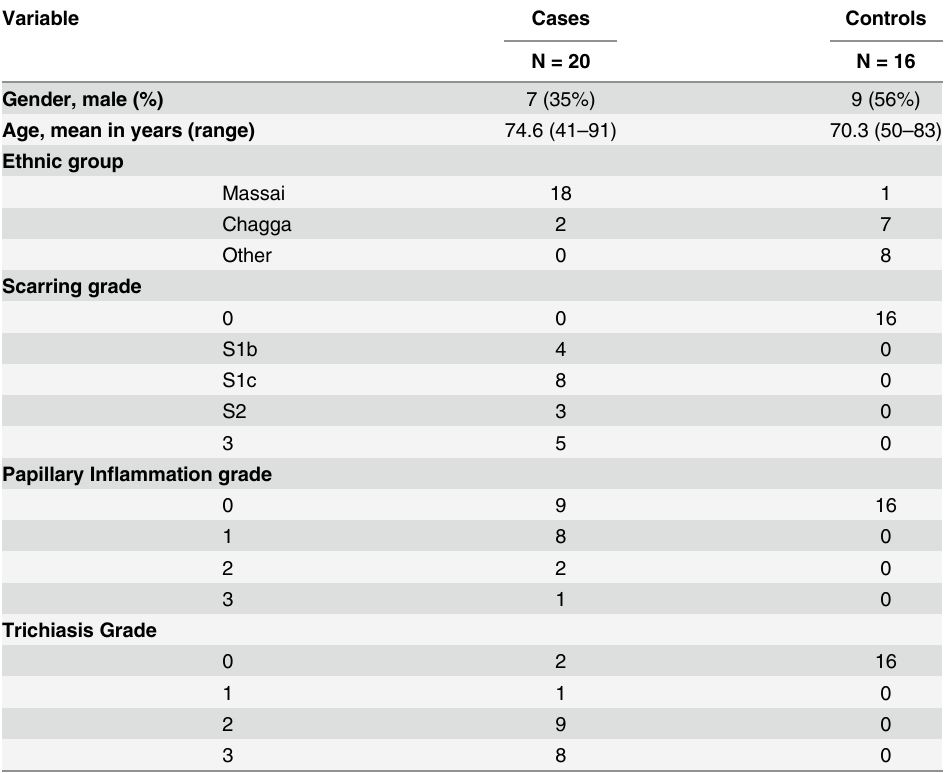
Table 1. Demographic and clinical characteristics of